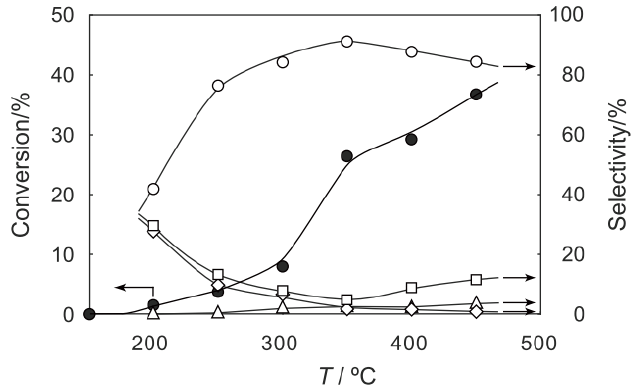
Cl )Cl (H O) ]·4H O/SiO . Following the activation of the 6 12 2 2 4 2 2